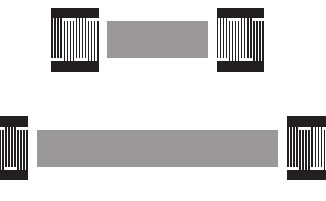
Figure 2. Delay lines of different length.